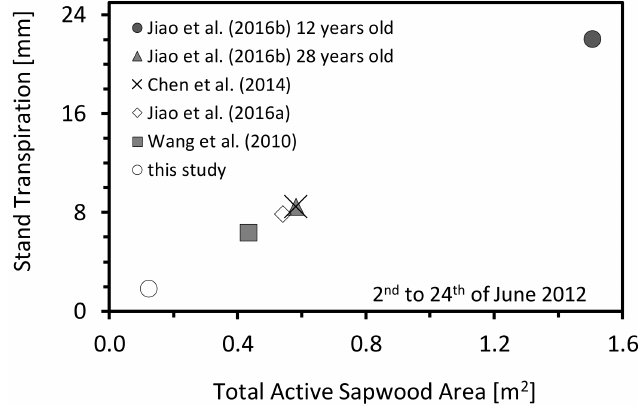
Figure 5. The possible impact of total active sapwood area on stand transpiration